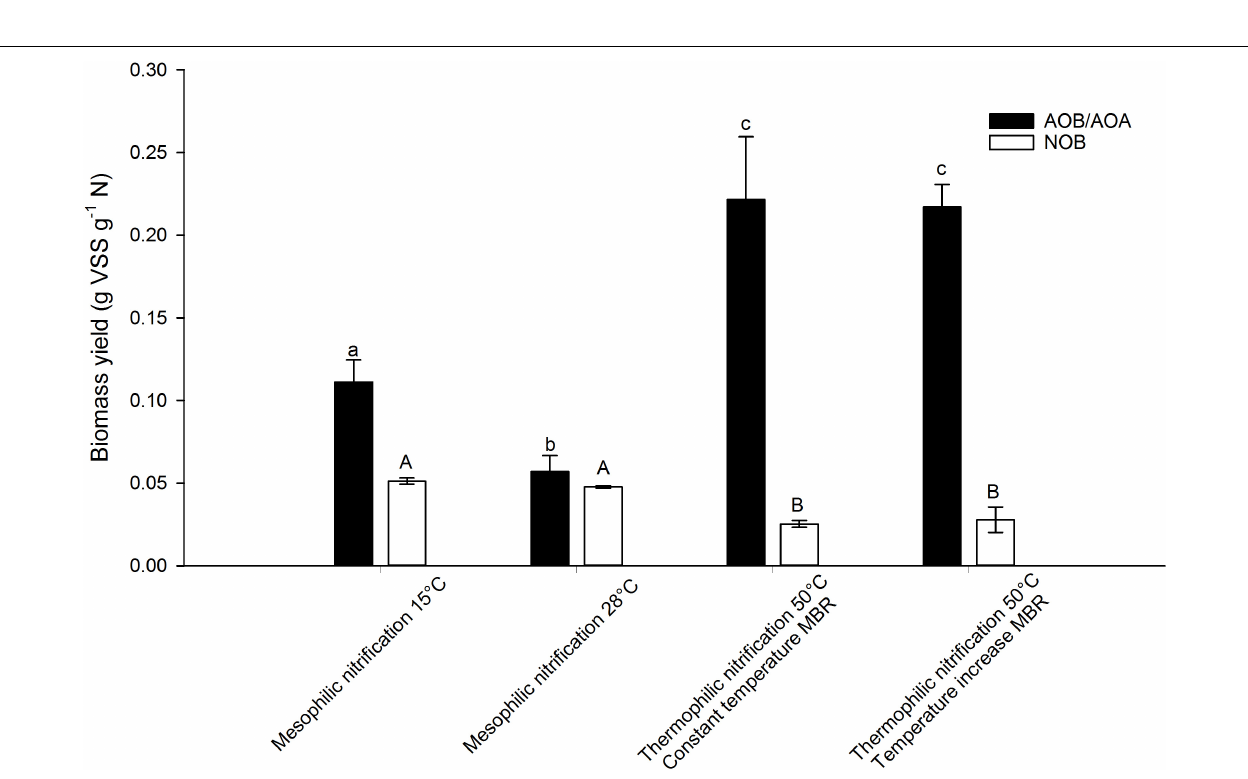
Frontiers in Microbiology |